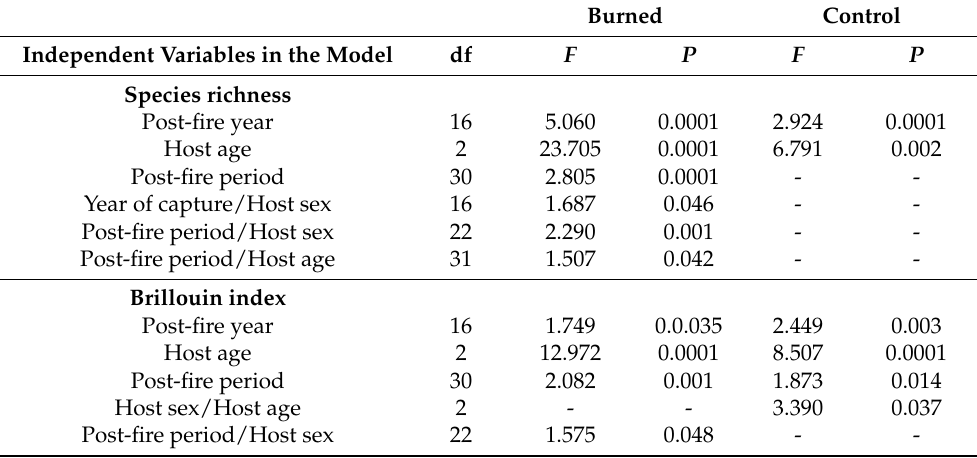
Table 11. ANOVA models for values of species richness and the Brillouin index of the wood mouse by year and period of capture, host age and host sex, in the burned and control areas, expressed by F values with associated probabilities ( P ) for the model created including independent variables. df = degree of